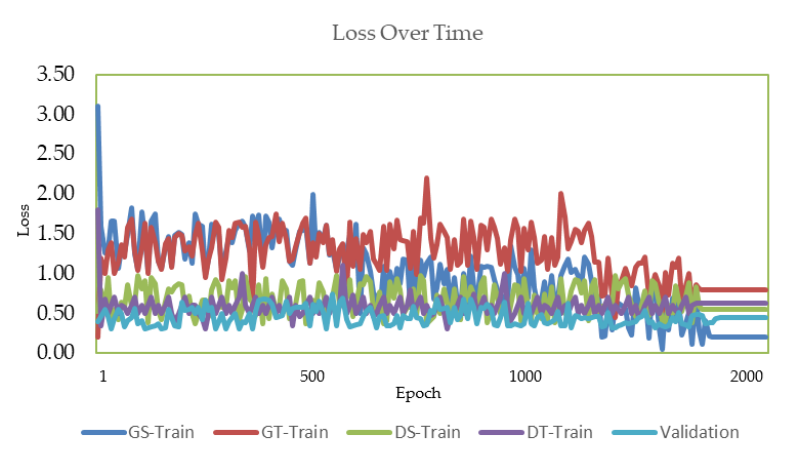
Figure 11. Loss over time for training and